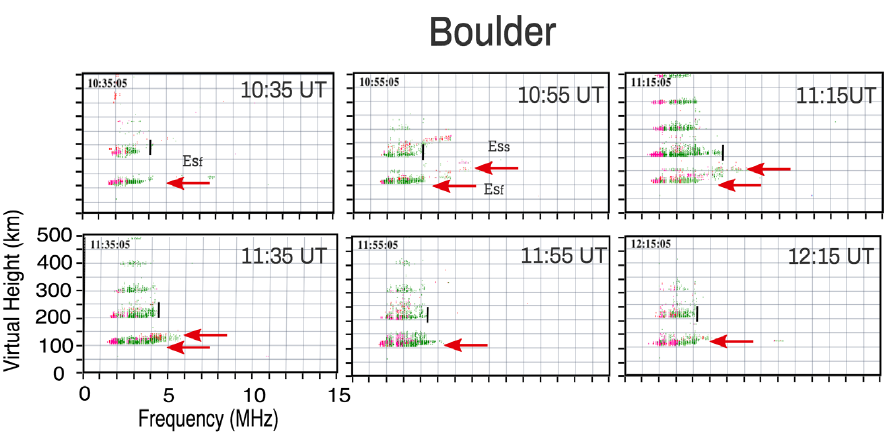
Figure 9. Ionograms collected at Boulder during the main geomagnetic storm phase show the Es s layer and Es f spreading, associated with the gravity waves and the Kelvin–Helmholtz Instability, respectively.